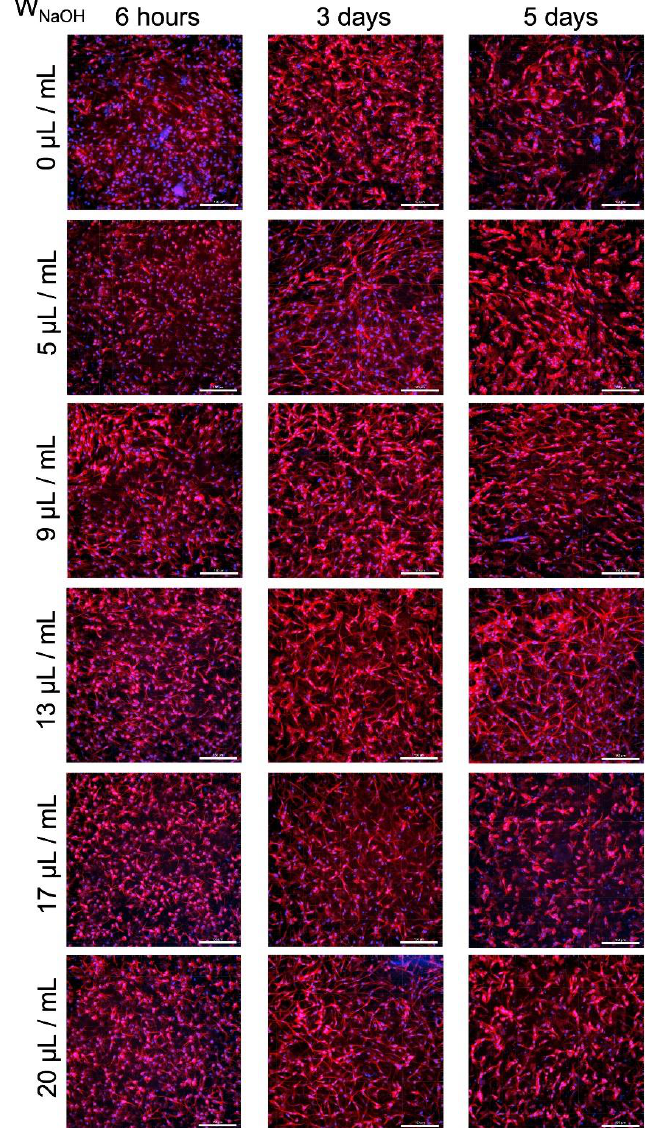
Figure 8. Comparison of the morphology of cells in samples with various NaOH concentrations after 6 h, and 3 and 5 days of cultivation. Cells in all samples were initially well grown, although lower cell densities were evident in sample 0. On the fifth day of cultivation, there were significant differences between the samples. F-actin in the cell cytoskeleton was stained with TRITC-conjugated phalloidin. Cell nuclei were counterstained with DAPI. Confocal microscope with spinning disc Nikon CSU-W1, objective CFI Plan Apo Lambda 20 × , scale bar 150 µ